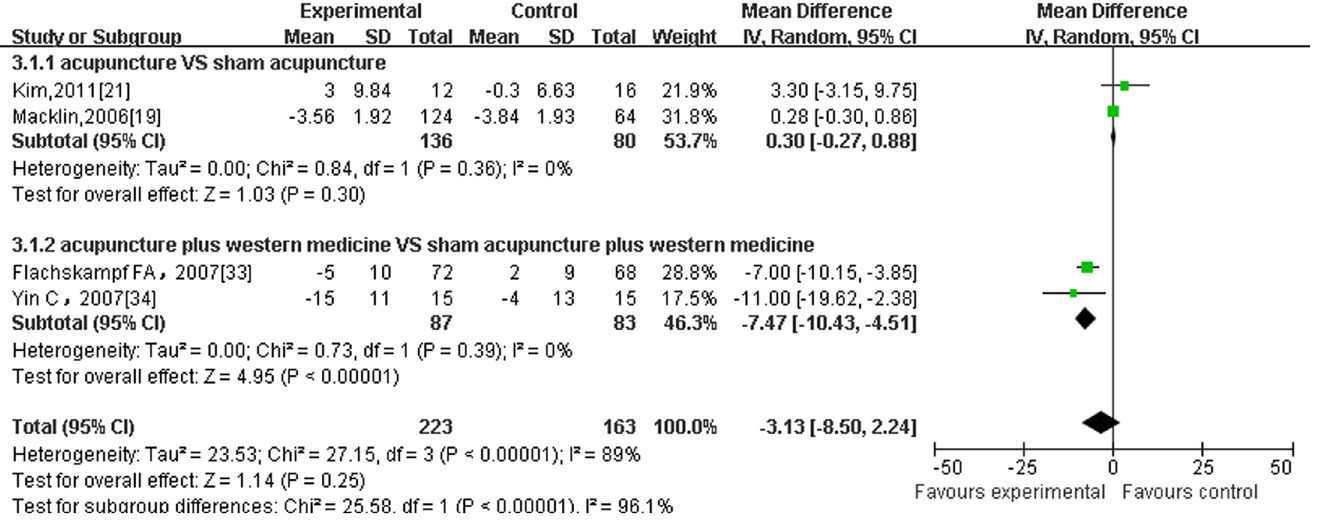
Fig 4. The forest plot of outcome measure ‘ SBP change magnitude. ’